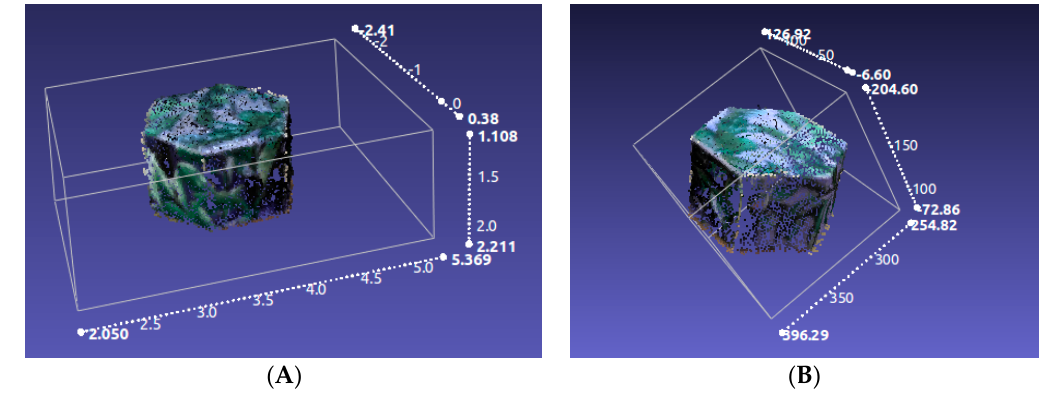
Figure 6. Hexagon box with texture.